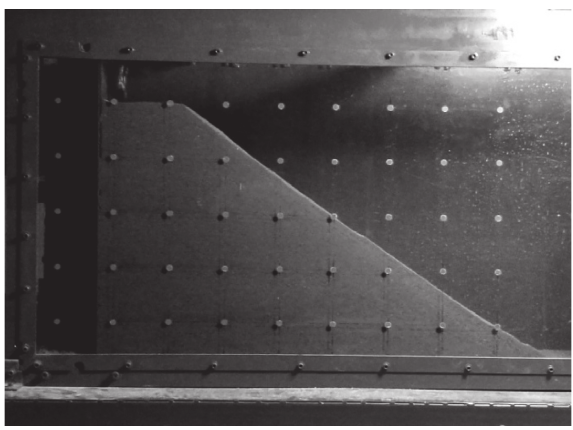
Figure 11: The test box.